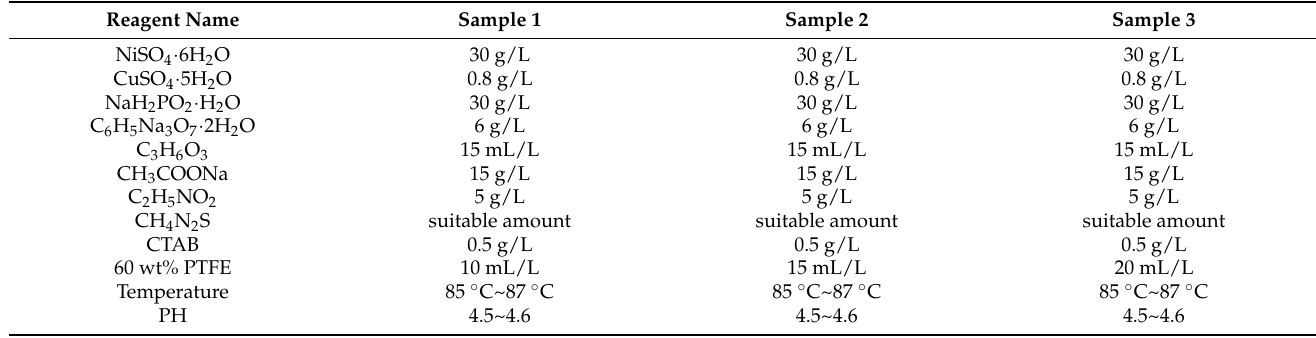
Table 1. Composition and technological conditions of Ni-Cu-P-PTFE plating